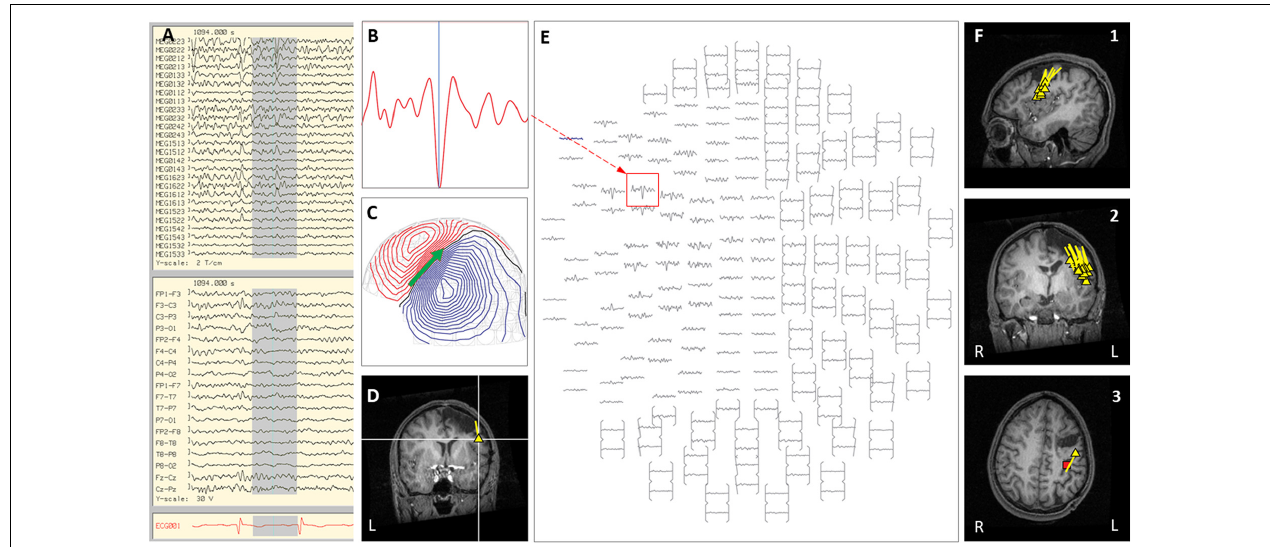
FIGURE 7 | Case 32 (A–E) provide an example of an individual simultaneous MEG–EEG seizure onset in the left intra-Sylvian area. (B) Selected MEG channel and time instance of the magnetic field distribution (C) in sensor space with the projected source estimate (green arrow). The coronal MRI slices (D) indicates the origin (triangle) and source orientation (tail) of the discharge (highlighted in A ). The MEG channel plot (E) of the selected time interval as shown in (A) shows the region of interest and the planar gradiometer channel (red square) with the earliest peak time. The summary pictures (F1–F3) gives an impression of the epileptiform activity before surgery (yellow triangles) originating from an area inferior to the prior laser-ablation cavity. The red square marks the source of the tactile somatosensory